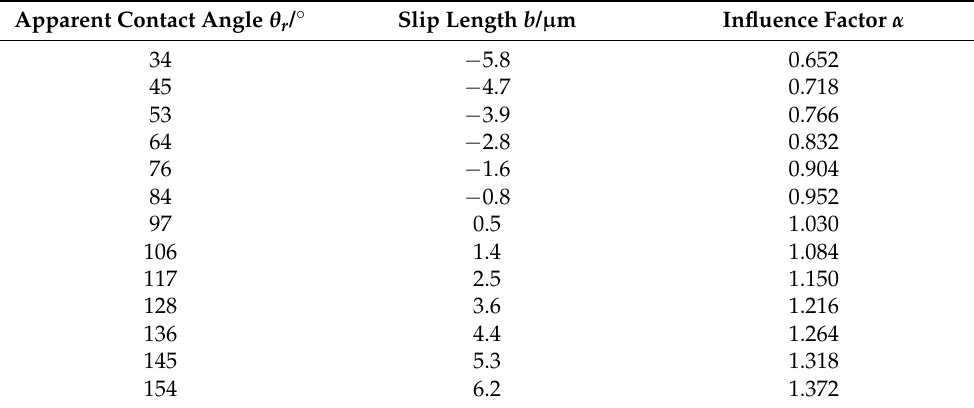
Table 2. The influence of apparent contact angle on the influence